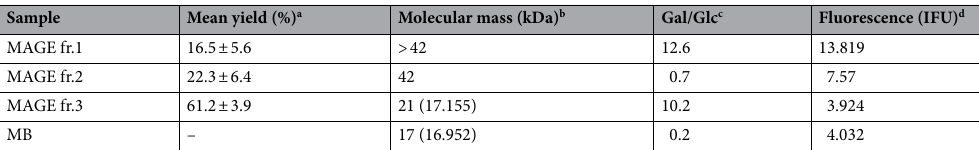
Table 1. Analysis of the products present in fractions after separation of MAGE (MB-mel) on a Sephadex G-200 column. a Calculated as the percentage of total weight of the collected material; mean of 5 experiments. b Counted from the migration in SDS–polyacrylamide gel; in parentheses values from MALDI-MS spectra are given. c Measured using GLC-MS method. d Intensity of fluorescence emission at 440 nm after excitation with a wavelength of 370 nm, expressed as the arbitrary intensity fluorescence units [IFU] per 0.5 mg protein from a representative experiment. Each value is averaged from three